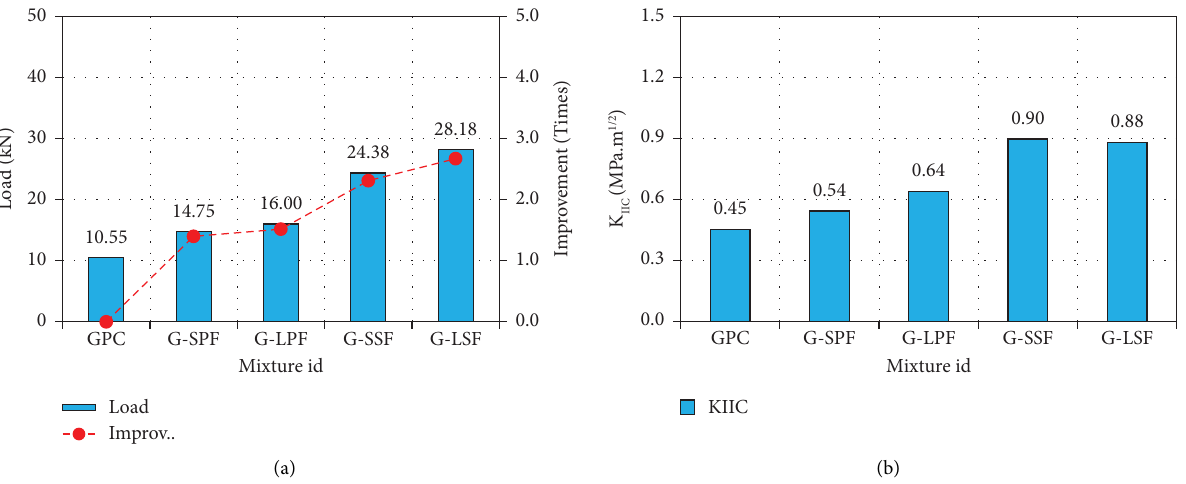
Figure 10: Mode II fracture toughness of specimens under 28.83 °